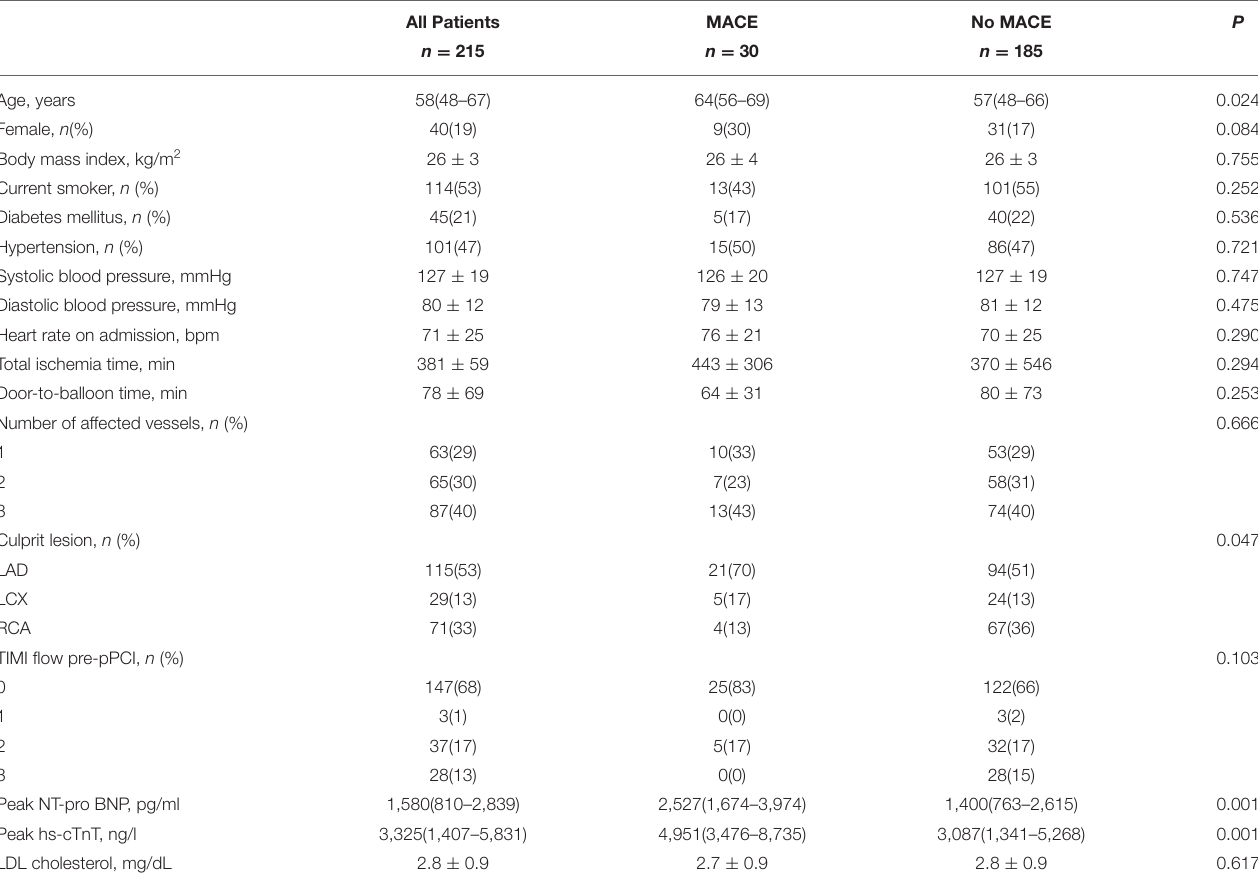
TABLE 1 | Patient